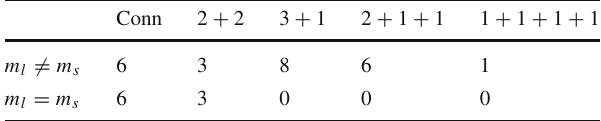
Fig. 1 Five Wick-contraction topologies that are necessary for the cal- culation of a hlbl μ as listed in Table 1. For each diagram, nontrivial per- mutations of the four quark-photon vertices yield the number of con- Table 1 Number of contractions needed for each type of diagram in Fig.